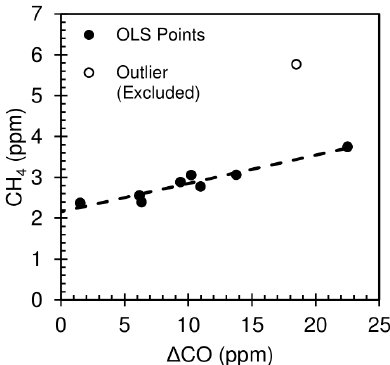
Figure 3. CH 4 vs ∆ CO for the nine VOC canister samples, showing the eight fit points (with the Figure 3. CH 4 vs Δ CO for the nine VOC canister samples, showing the eight fit points (with the ordinary least squares regression line) and the one outlier ordinary least squares regression line) and the one outlier point.